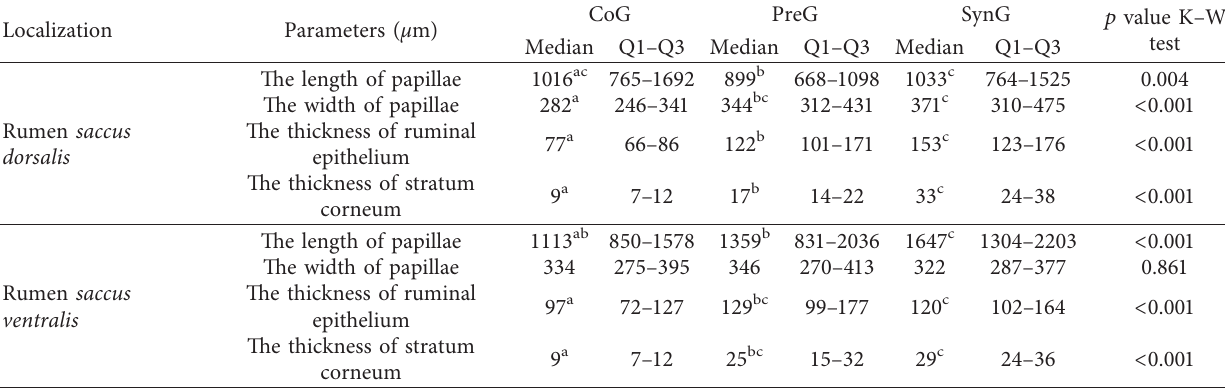
Table 3: Results of histological examination of the rumen.